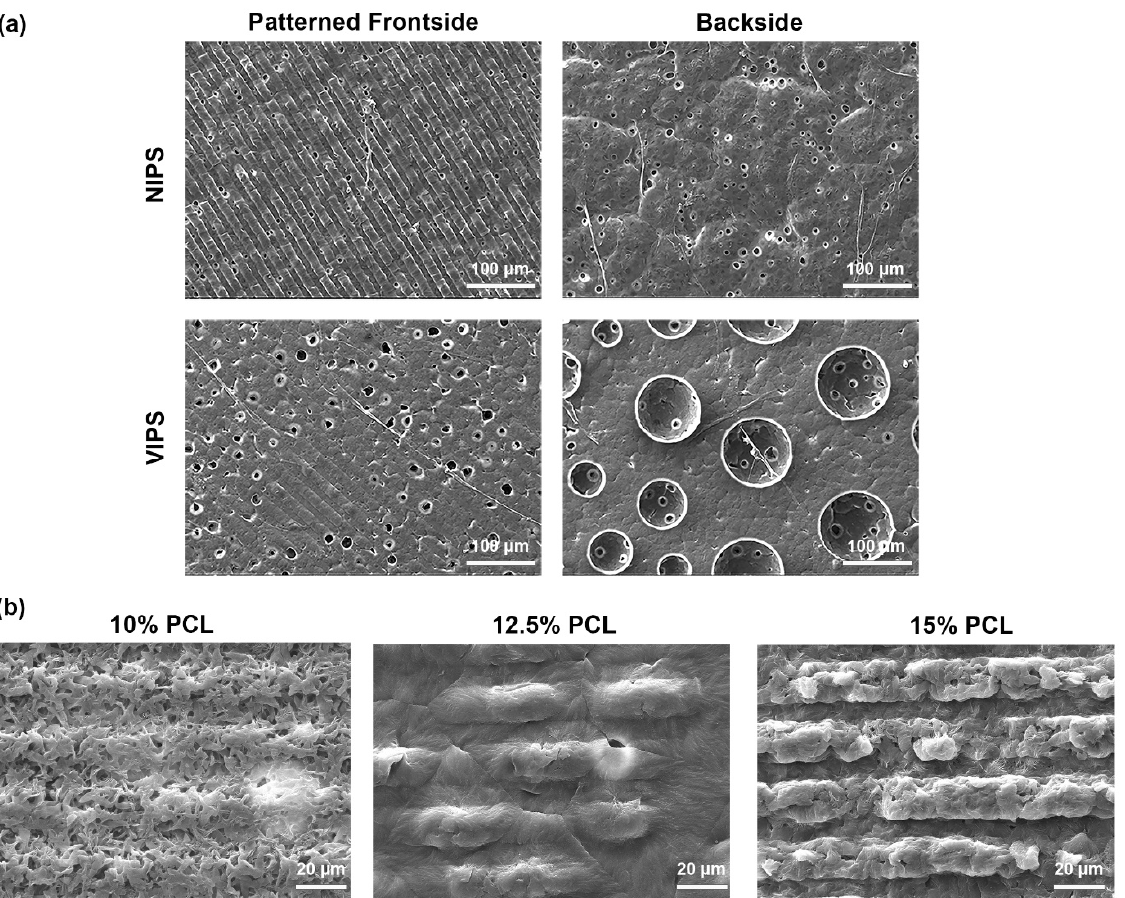
Figure 2. Preliminary SEM evaluations. ( a ) Morphological comparison of PCL membranes produced by NIPS and VIPS methods via SEM. While pattern formation occurs on the frontside of NIPS-applied membranes, this is not the case for those produced with VIPS. Note the 5–10 µm-sized holes on the backside of the NIPS membrane, and the 50–100 µm-diameter craters on the backside of the VIPS membrane. ( b ) Comparison of pattern formation levels when using different PCL concentrations.